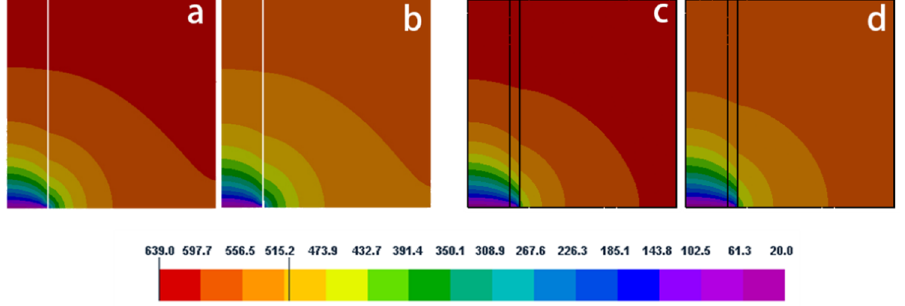
Figure 3. Temperature profile in axial section of the model without coating ( a , b ) and with coating ( c , d ) at different dimensionless times ( a , c ) Fo = 0.156, ( b , d ) Fo = 0.234.